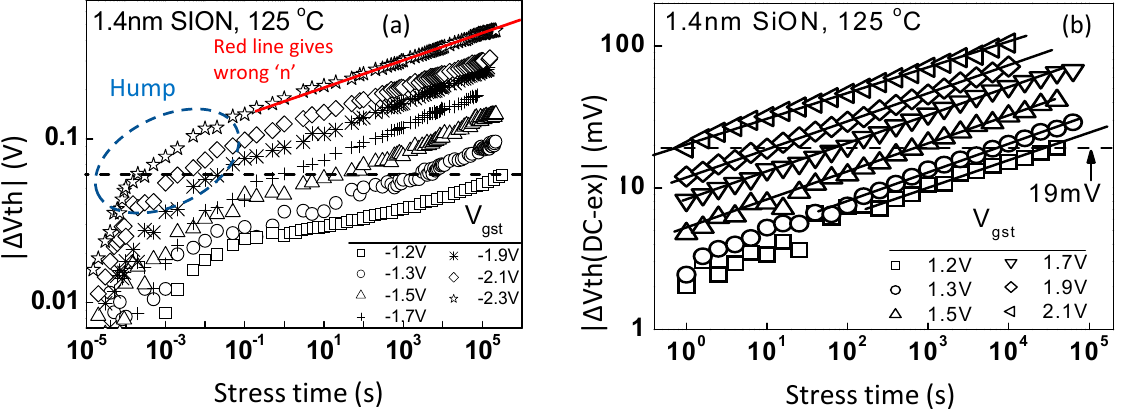
Figure 5. NBTI-induced positive charges with different HfSiON thicknesses. Symbols are test data.